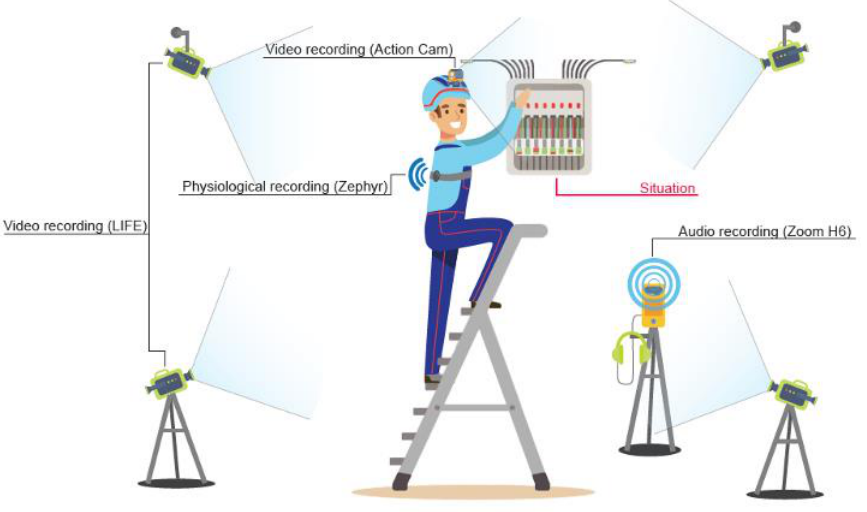
Figure 2. Location of the cameras.